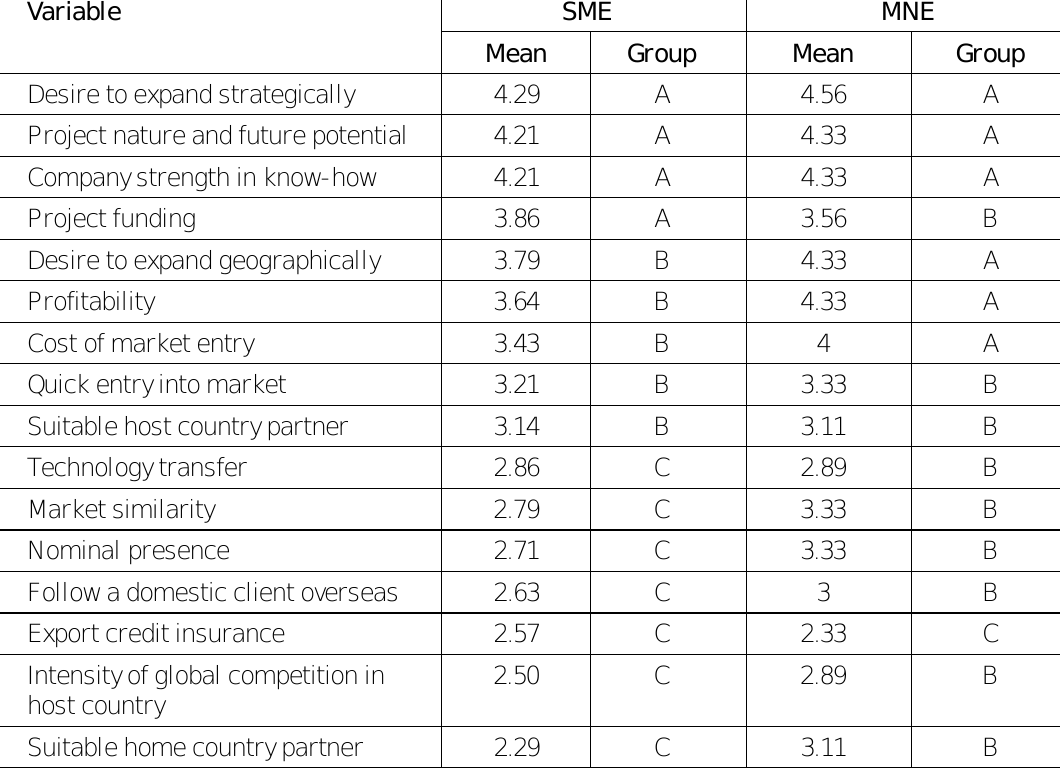
Table 1: Company-specific factors, descending means and sub-groups Variable SME MNE Mean Group